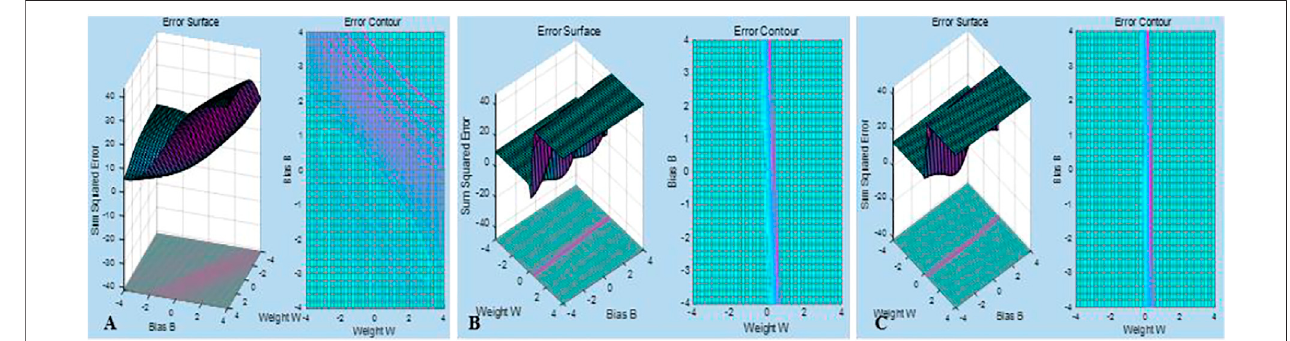
The algorithm iteration process of the BP algorithm,